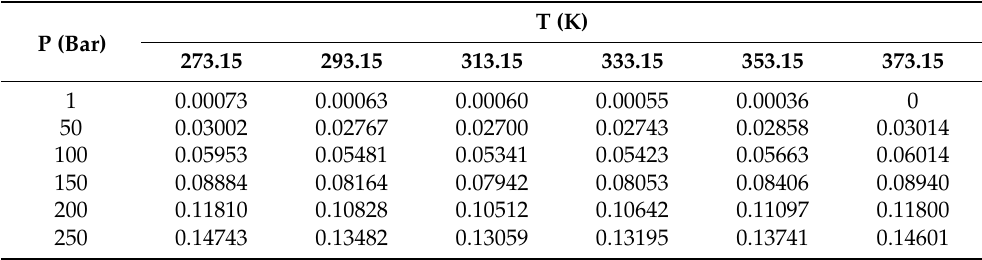
Table 5. Calculated H 2 solubility (mol/kg) in a 1 mol/kg NaCl solution.